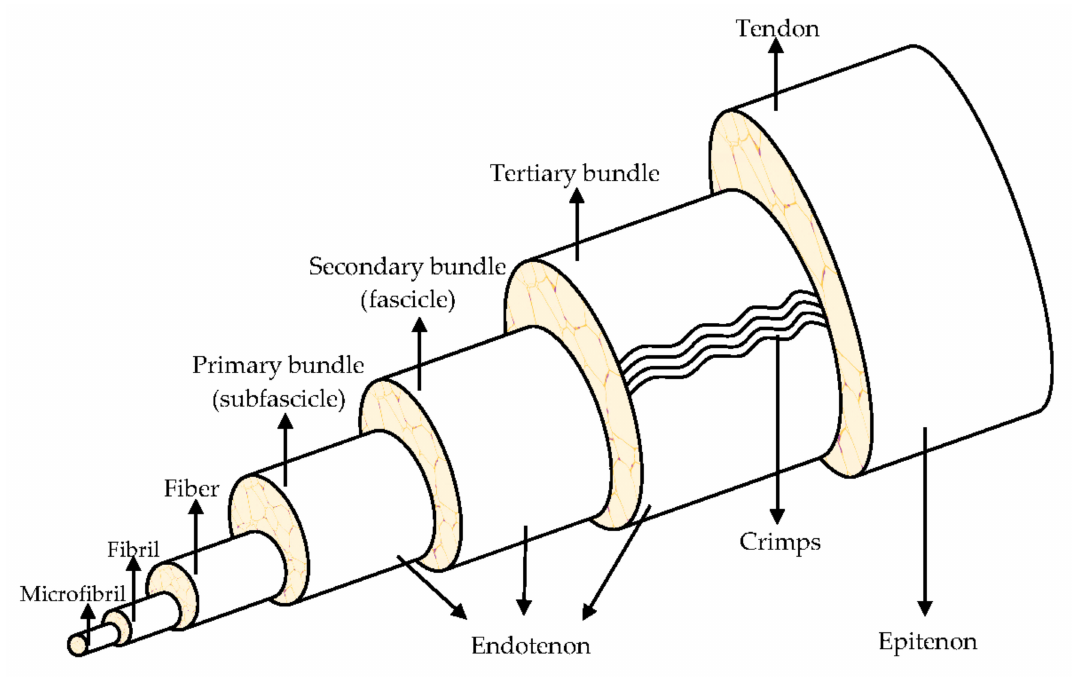
Figure 1. Hierarchical structure of the tendon. Modified from